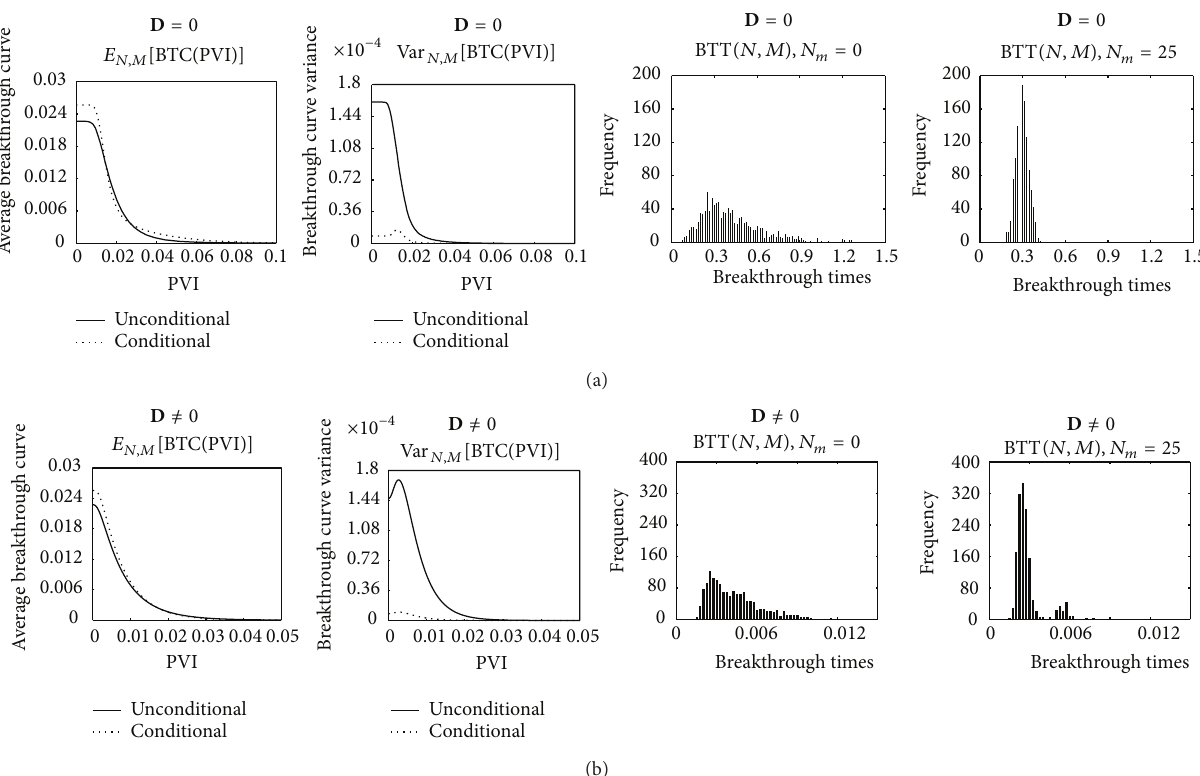
Figure 10: Example from Section 4.2. In each row we show expectations (far left) and variances (left) approximated with 𝑀 = 1600 unconditional and conditional realizations and histograms of unconditional (right) and conditional (far right) breakthrough times. The rows correspond to the cases with D = 0 (a) and D ̸= 0 (b).